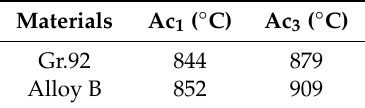
Figure 14. Nano-SIMS distribution map of sputtered carbon, boron, chromium, and iron ions in the areas denoted by the arrows of the alloy B specimens heat-treated under the 1050 ◦ C, 6 min and 800 ◦ C, 6 min conditions: ( a ) #1 ( b ) #2. Table 2. Phase transformation temperatures for alloy B and Gr.92 steels [32].